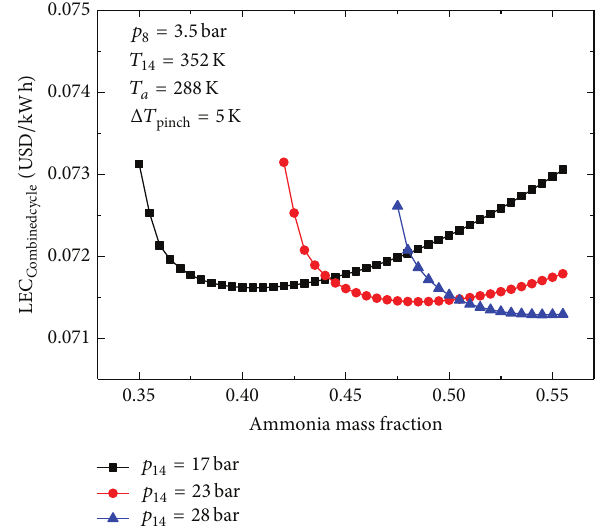
Figure 14: Variation of power output of combined cycle with ammonia mass fraction.